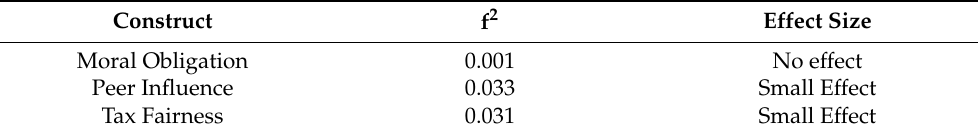
Table 6. Effect sizes, f 2 .